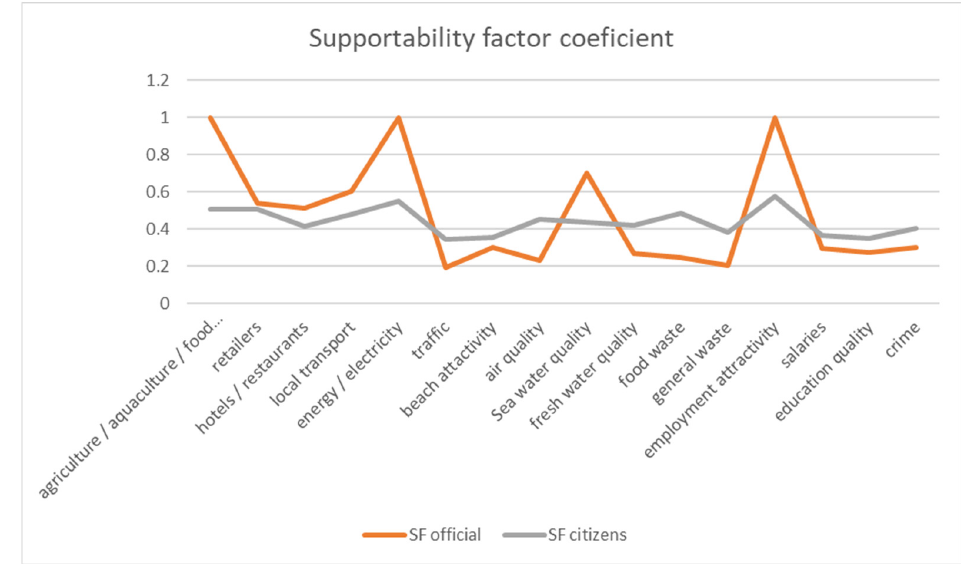
Figure 6. A graphical analysis of the activities in the Constanta coastal area (Romania).